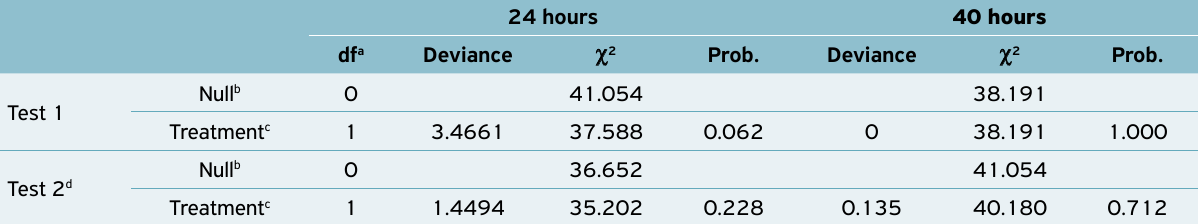
Table 2. Number of lettuce leaves with signs of feeding by Gryllus sp. in the presence (treatment) or absence (null) of Steinernema carpocapsae All over time in the test with no chance of choice.